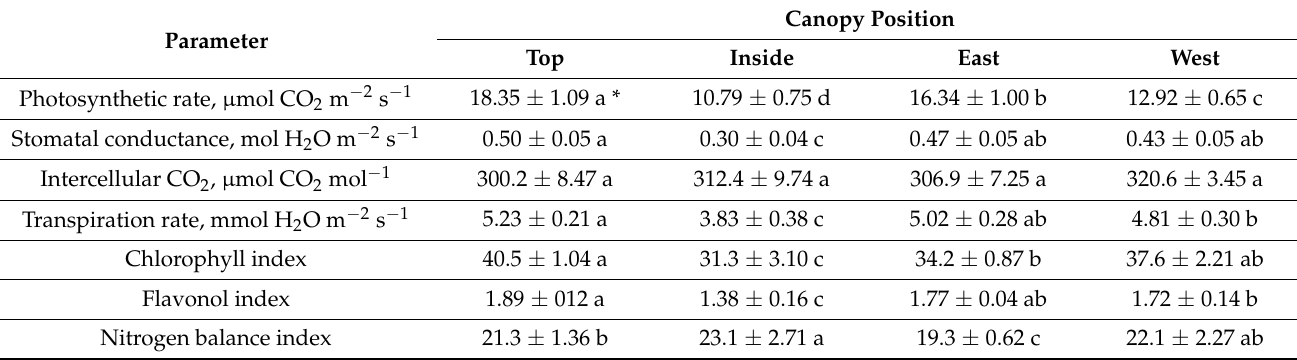
Table 1. Effect of canopy position on photosynthetic parameters, average 2019–2020.